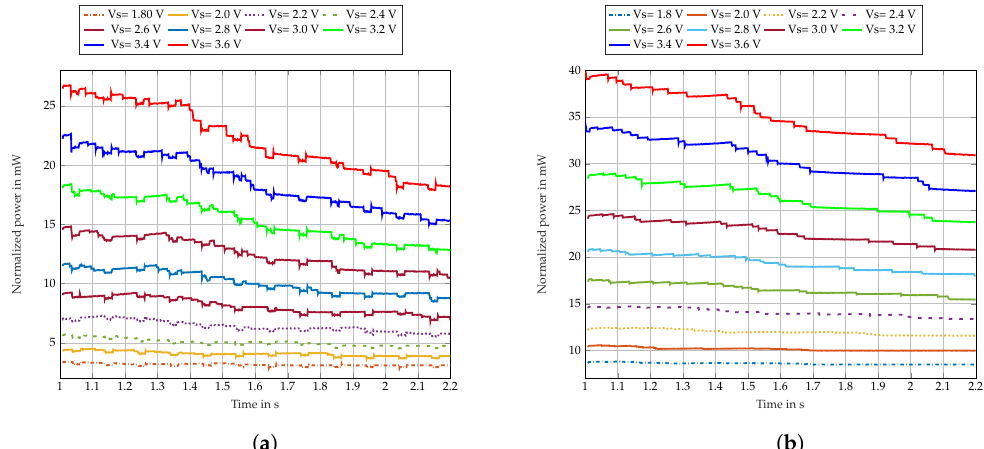
Figure 8. Normalized power during the time for different supply voltages at ( a ) 6 MHz; ( b ) 20